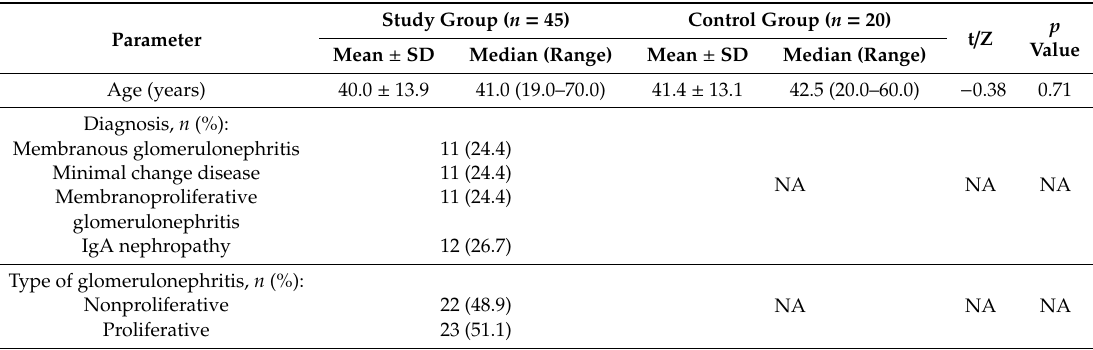
Table 6. Characteristics of the study and control